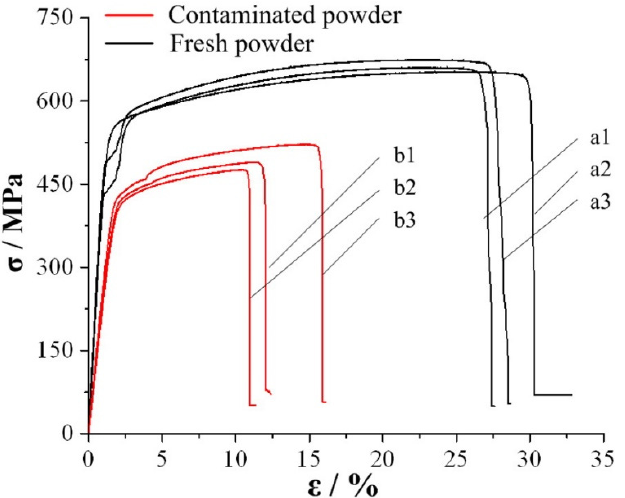
Figure 20. The stress–strain curves of tensile test pieces (fabricated from fresh and contaminated). (Reprinted with permission from Ref. [62]. Copyright 2015 Elsevier B.V.).